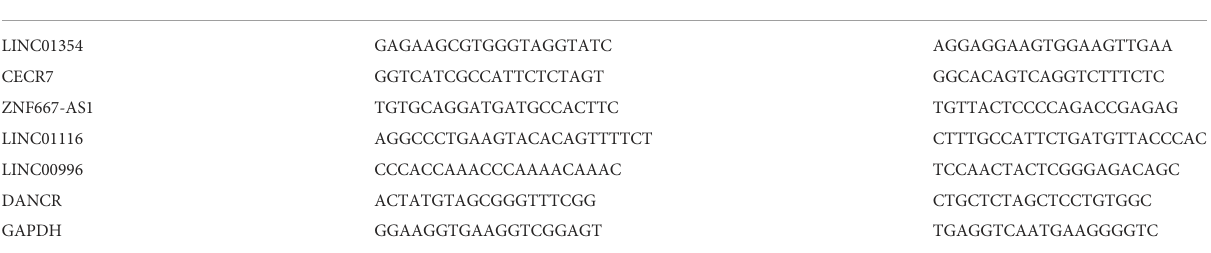
TABLE 1 Primers used in the current